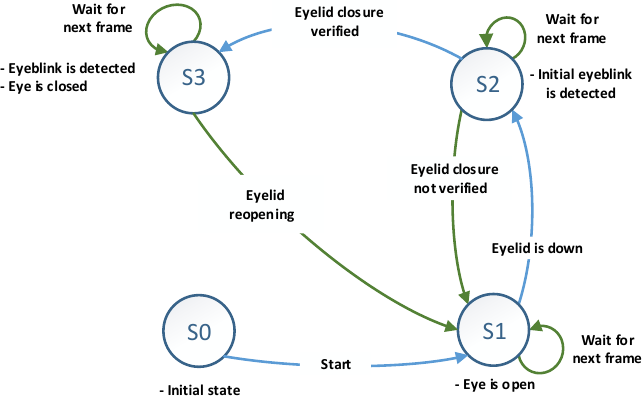
Figure 11. Finite state machine for identifying eyeblinks and tracking the eye state.